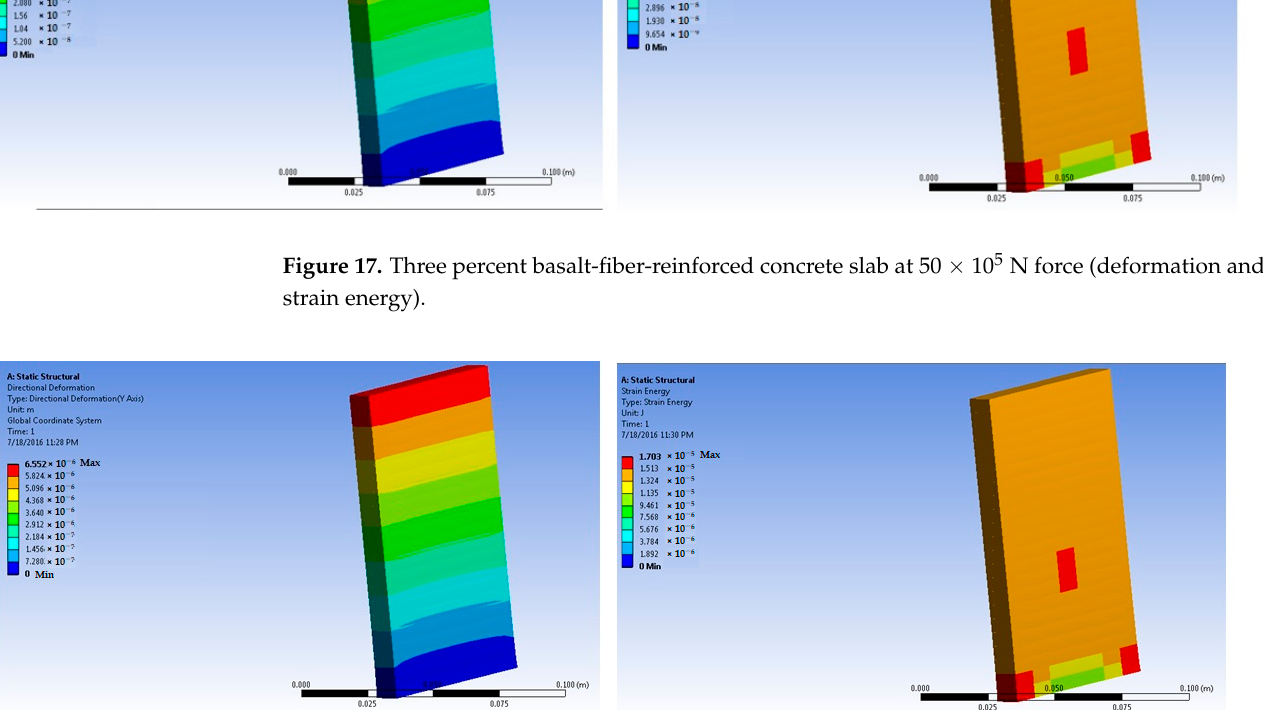
Figure 18. Three percent basalt-fiber-reinforced concrete slab at 700 × 10 5 N force (deformation and strain energy).